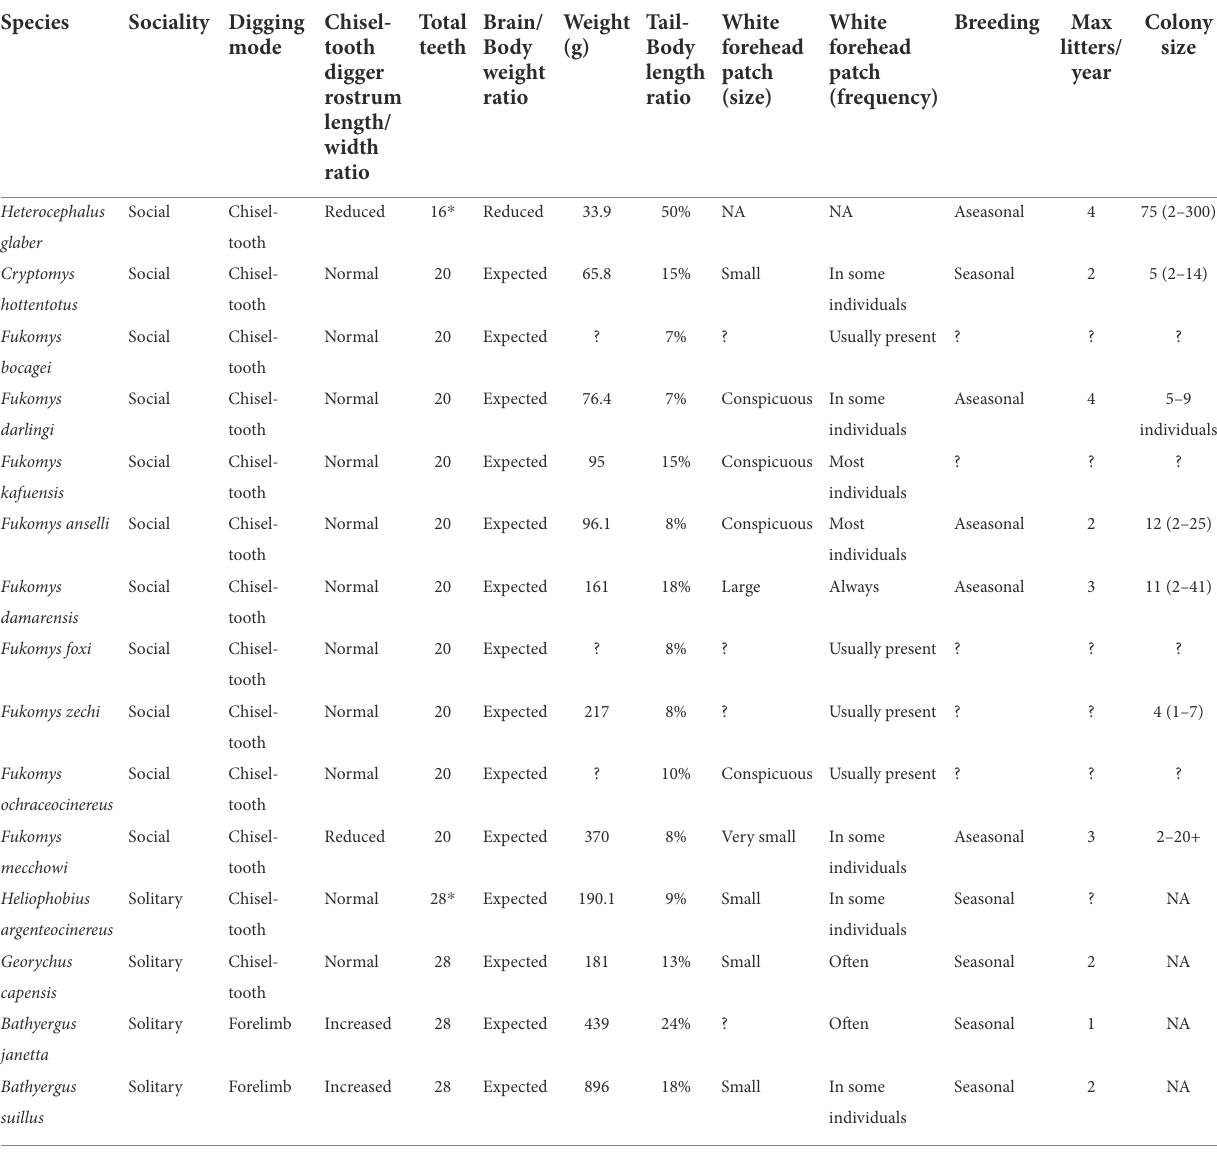
TABLE 1 Selected domestication syndrome traits in the African mole